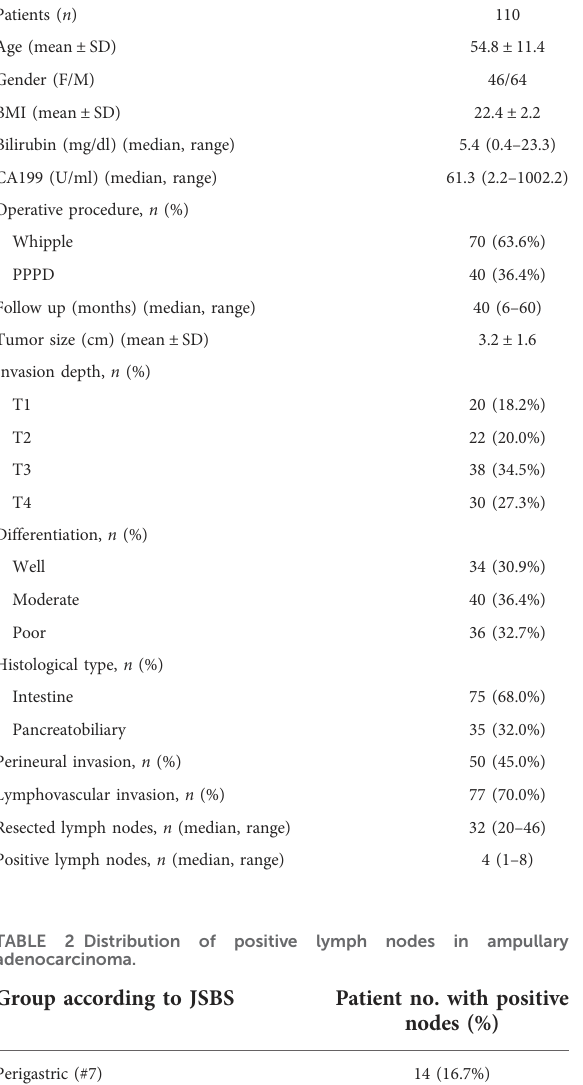
TABLE 1 Characteristics of 110 patients of ampullary adenocarcinoma.